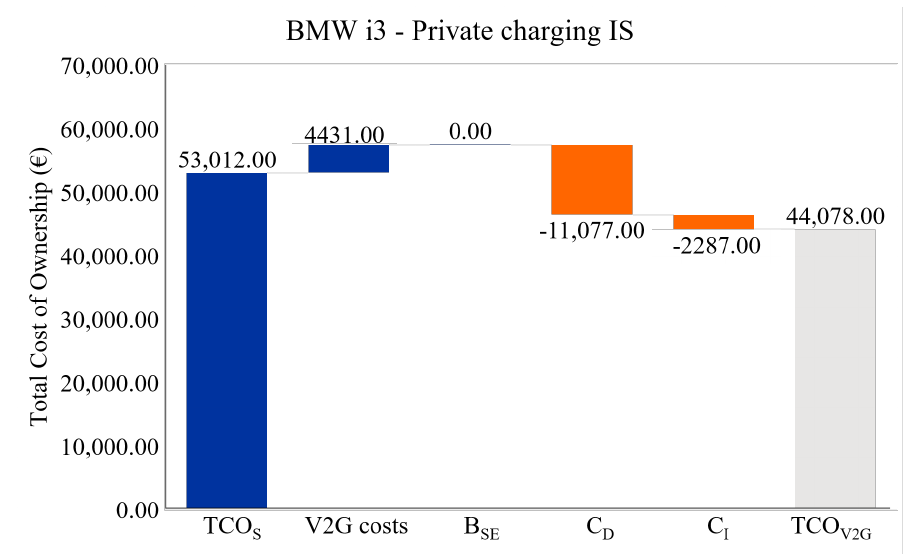
Figure A14. Standard and V2G TCO of a BMW i3 in a private charging case providing IS ( TCO S = Standard TCO, B SE = benefit of saved electricity costs from the grid, C D = direct com- pensation, C I = indirect compensation, TCO V 2 G = V2G TCO); source: own compilation).